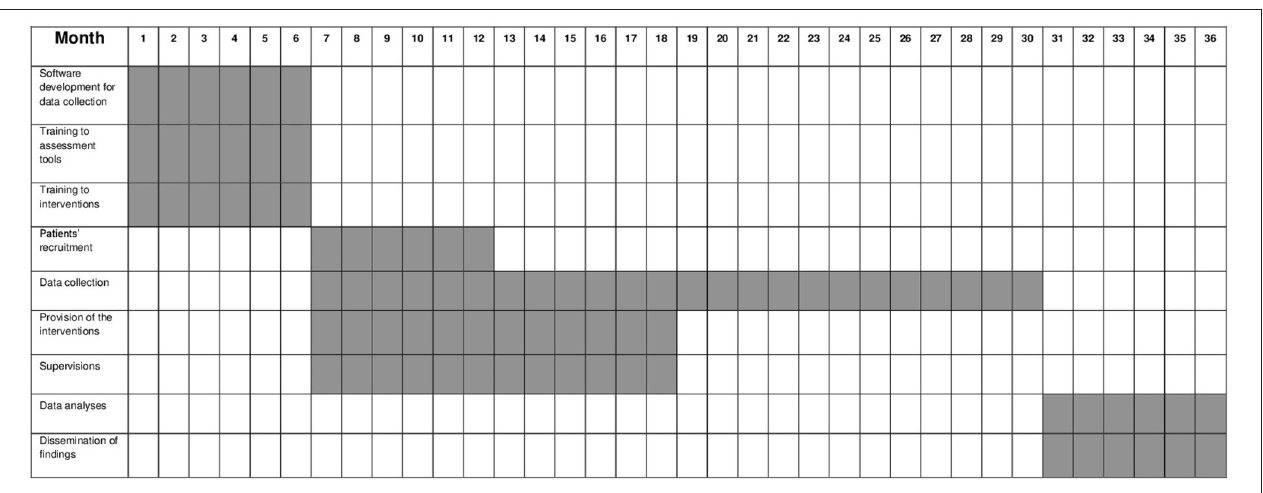
FIGURE 2 | Stepwise